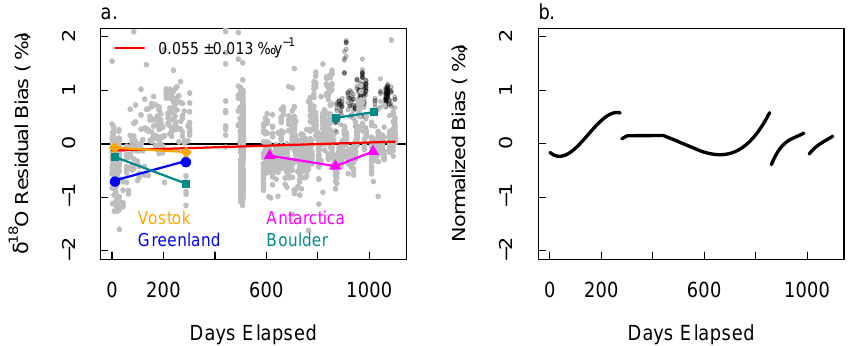
Figure 6. (a) The residual isotopic bias at Mauna Loa – after correcting the calibration data for concentration dependence and normalizing to the VSMOW-SLAP scale – plotted as a function of time (gray points). Long-term drift is estimated by the simple linear regression (red line), which is fit to all data except those associated with the second set of Boulder standard water (points with darker shading). Mean residual biases for 20-day periods following the replacement of each standard with new water are represented by the larger symbols and are colored by standard (see legend). (b) Cubic polynomials fit to gray points in panel (a) – once normalized by isotopic standard for the four periods in which different standard bottles were used – indicate that the standards themselves may be drifting at Mauna